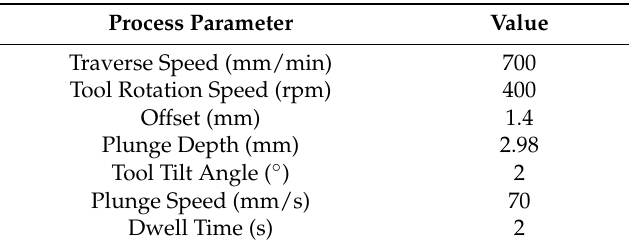
Table 2. Optimum friction stir welding parameters for uncoated blanks determined by a preliminary parametric investigation.